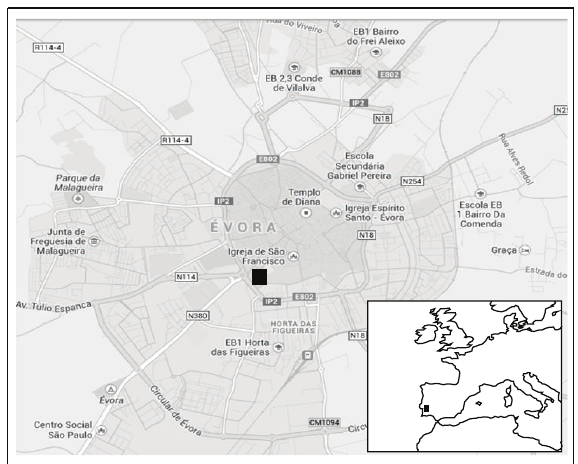
Figure 1: Map of the Iberian Peninsula showing ´Evora and map of ´Evora showing the location of ´Evora Geophysics Centre (CGE/black square)monitoring sitewithinthecity coreaswell as themain traffic